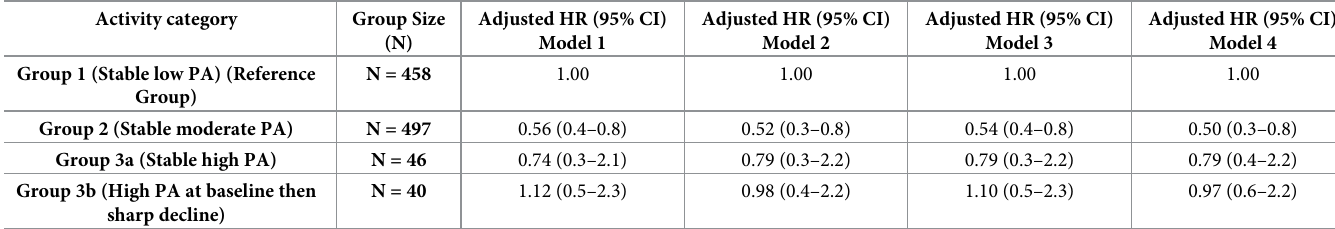
Table 3. All-cause mortality risk of the groups according to activity category using Cox regression models in a subgroup analysis. Activity